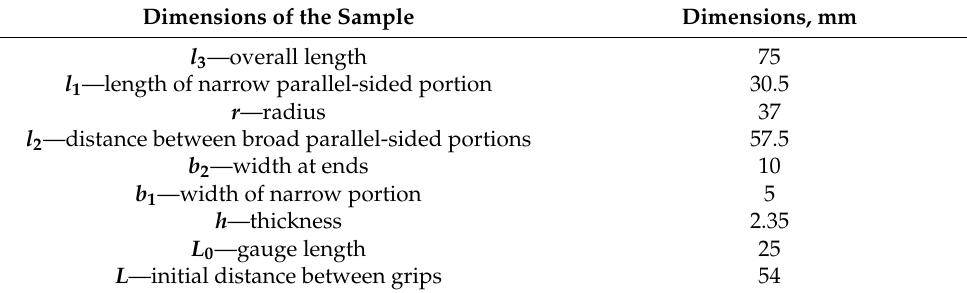
Figure 2. Sample type 1BA for strength tests. Table 1. Sample dimensions.